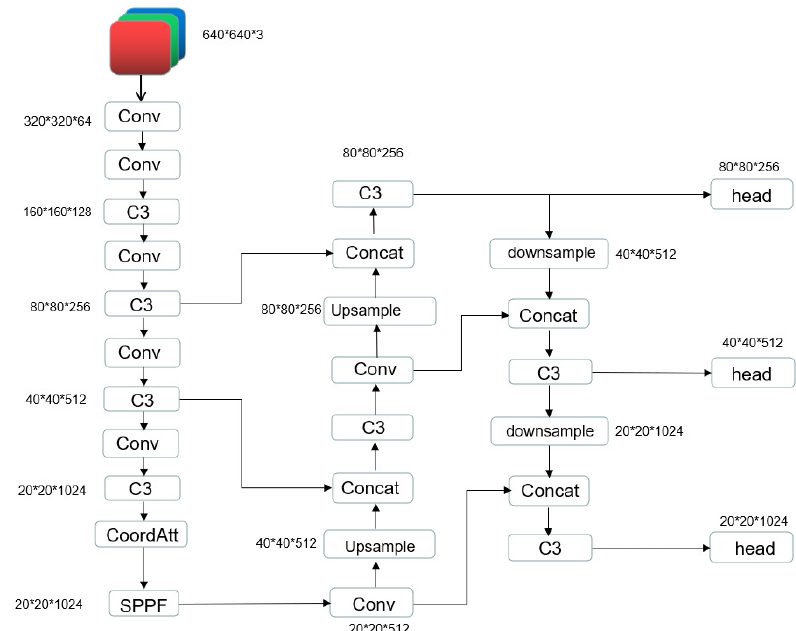
Figure 2. YOLOv5s network model with Coordinated